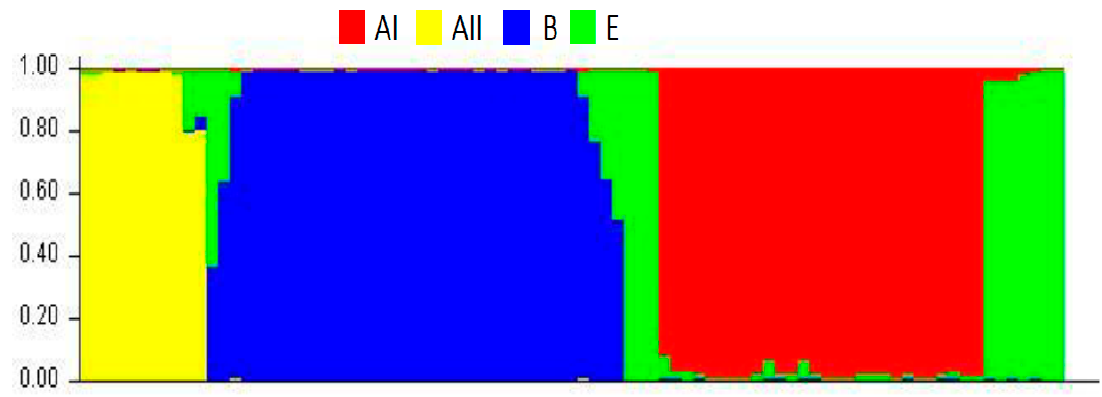
Figure 2. Analysis of STRUCTURE with the genome sequences. K = 4 populations were established a priori, corresponding to assemblages AI, AII, B and E. Colours indicate respective assemblages.